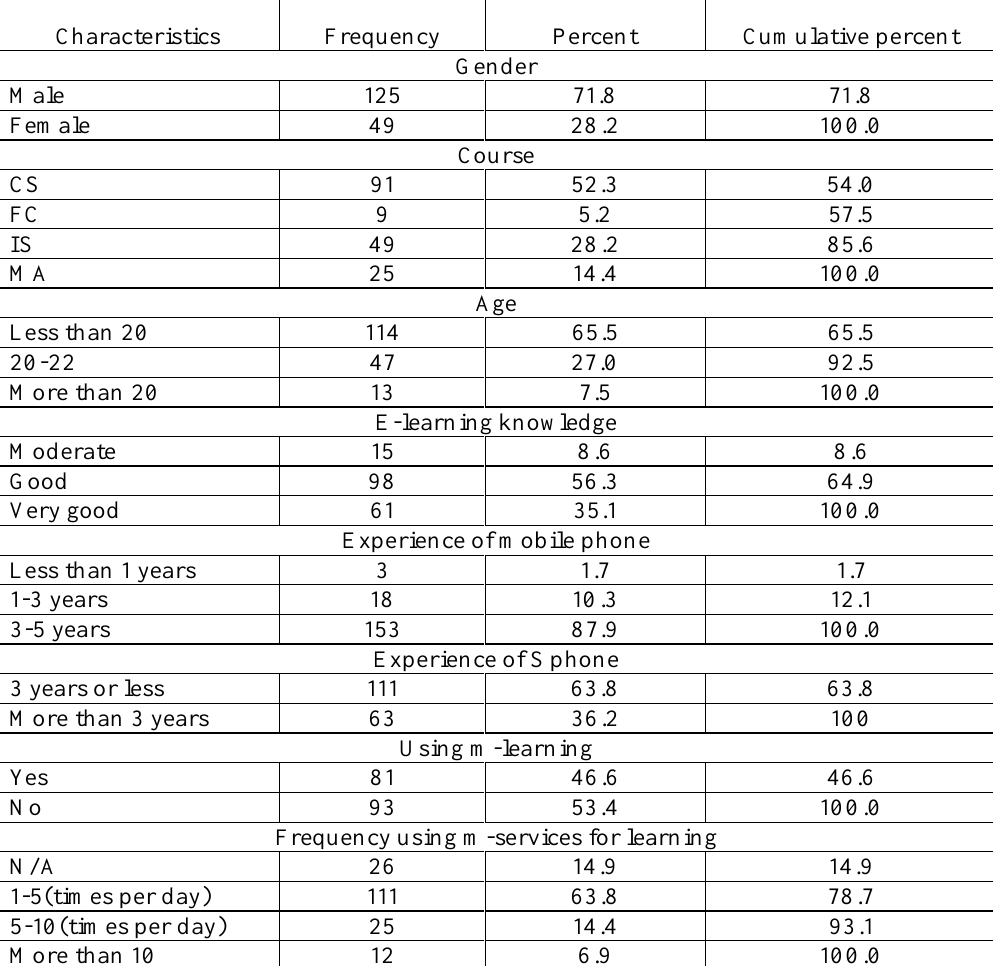
Characteristics of